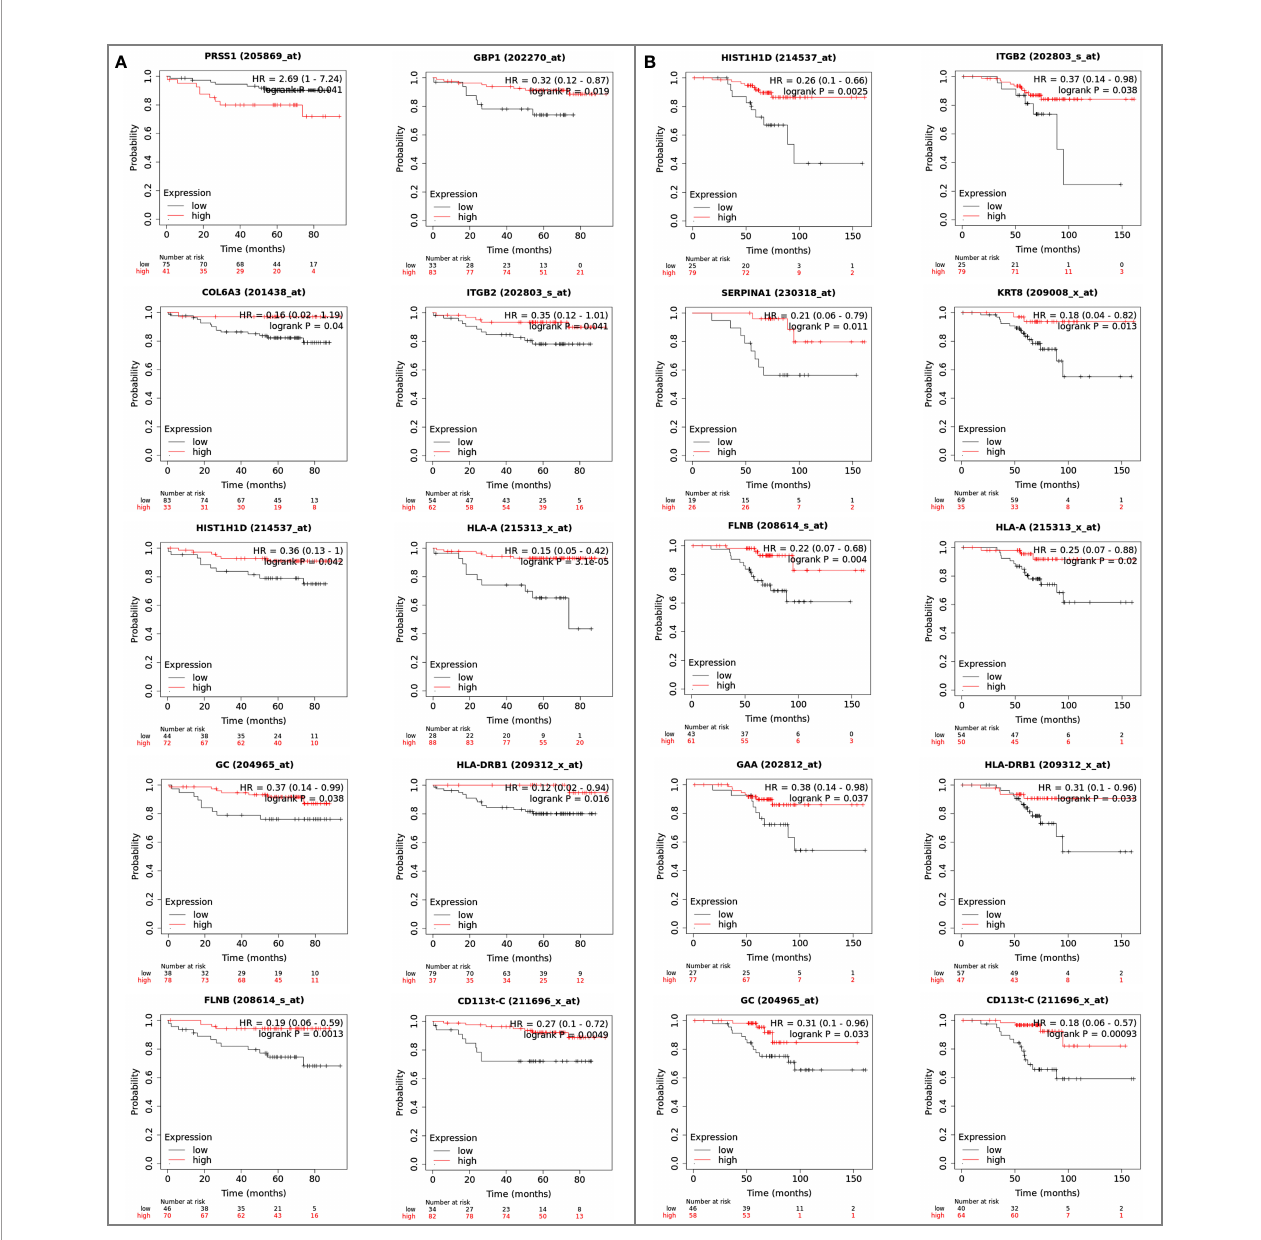
FIGURE 9 | Reference genes of the mutated proteins identi fi ed in the clonal proteome dataset associated with breast cancer (A) DMFS or (B) OS. The breast cancer Kaplan-Meier plotter tool was used to run multiple reference gene testing in publically available estrogen receptor positive and HER2 negative cohorts. A logrank p<0.05 was considered signi fi cant. DMFS, distant metastases free survival; HR, hazard ratio; OS, overall